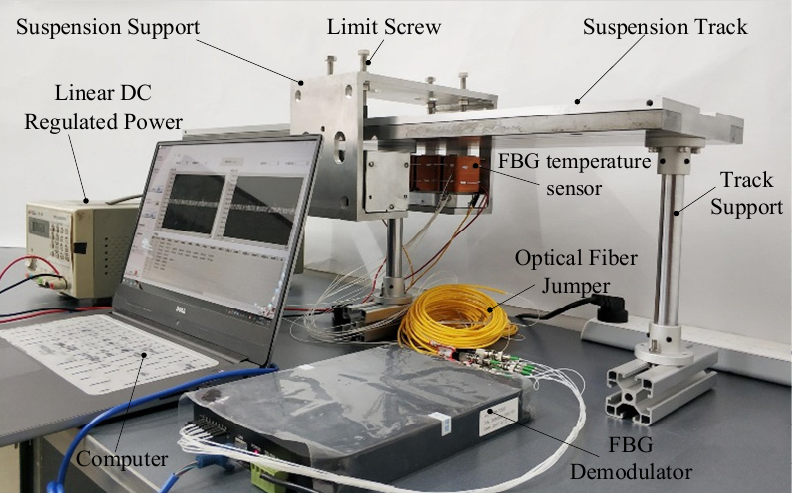
Figure 14. Temperature monitoring experimental platform.